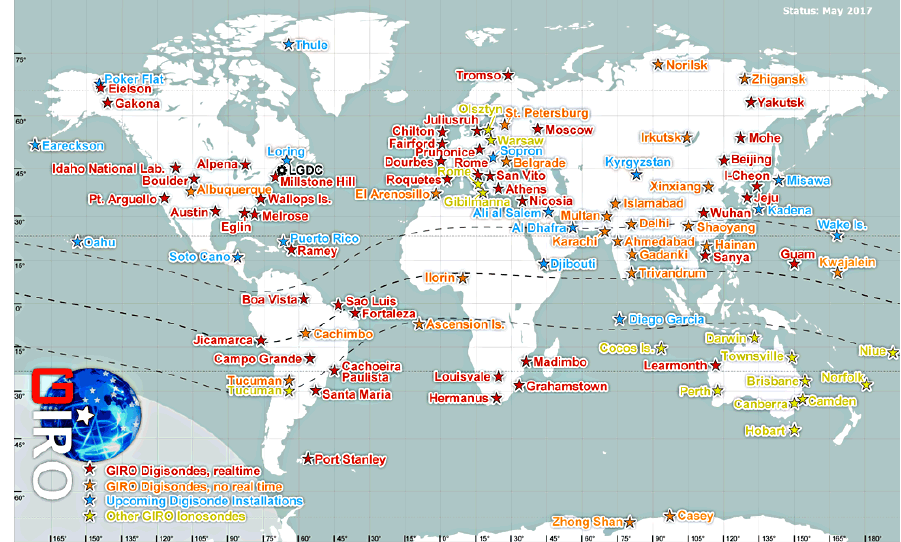
Figure 2. Map of digisondes contributing data to the Global Ionospheric Radio Observatory (GIRO). Red stars identify online digisondes providing data to GIRO in near-real-time, orange stars denote digisondes providing data to GIRO in no real time, yellow stars denote other type of ionosondes that also contribute to GIRO archives, and blue stars correspond to digisonde installations planned for the next